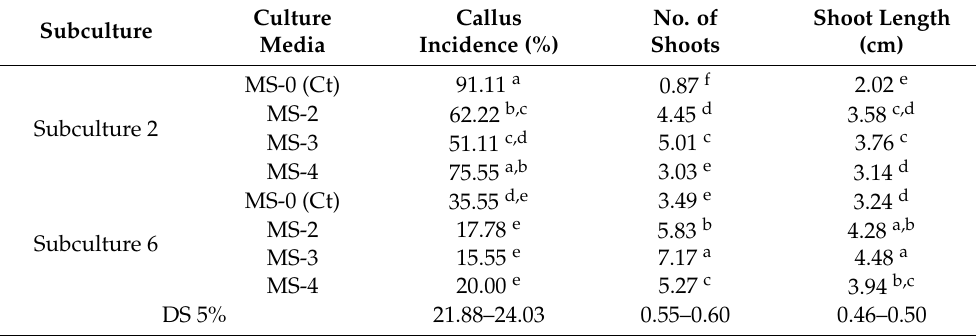
Table 7. Culture medium and subculture influence on the multiplication of microshoots.